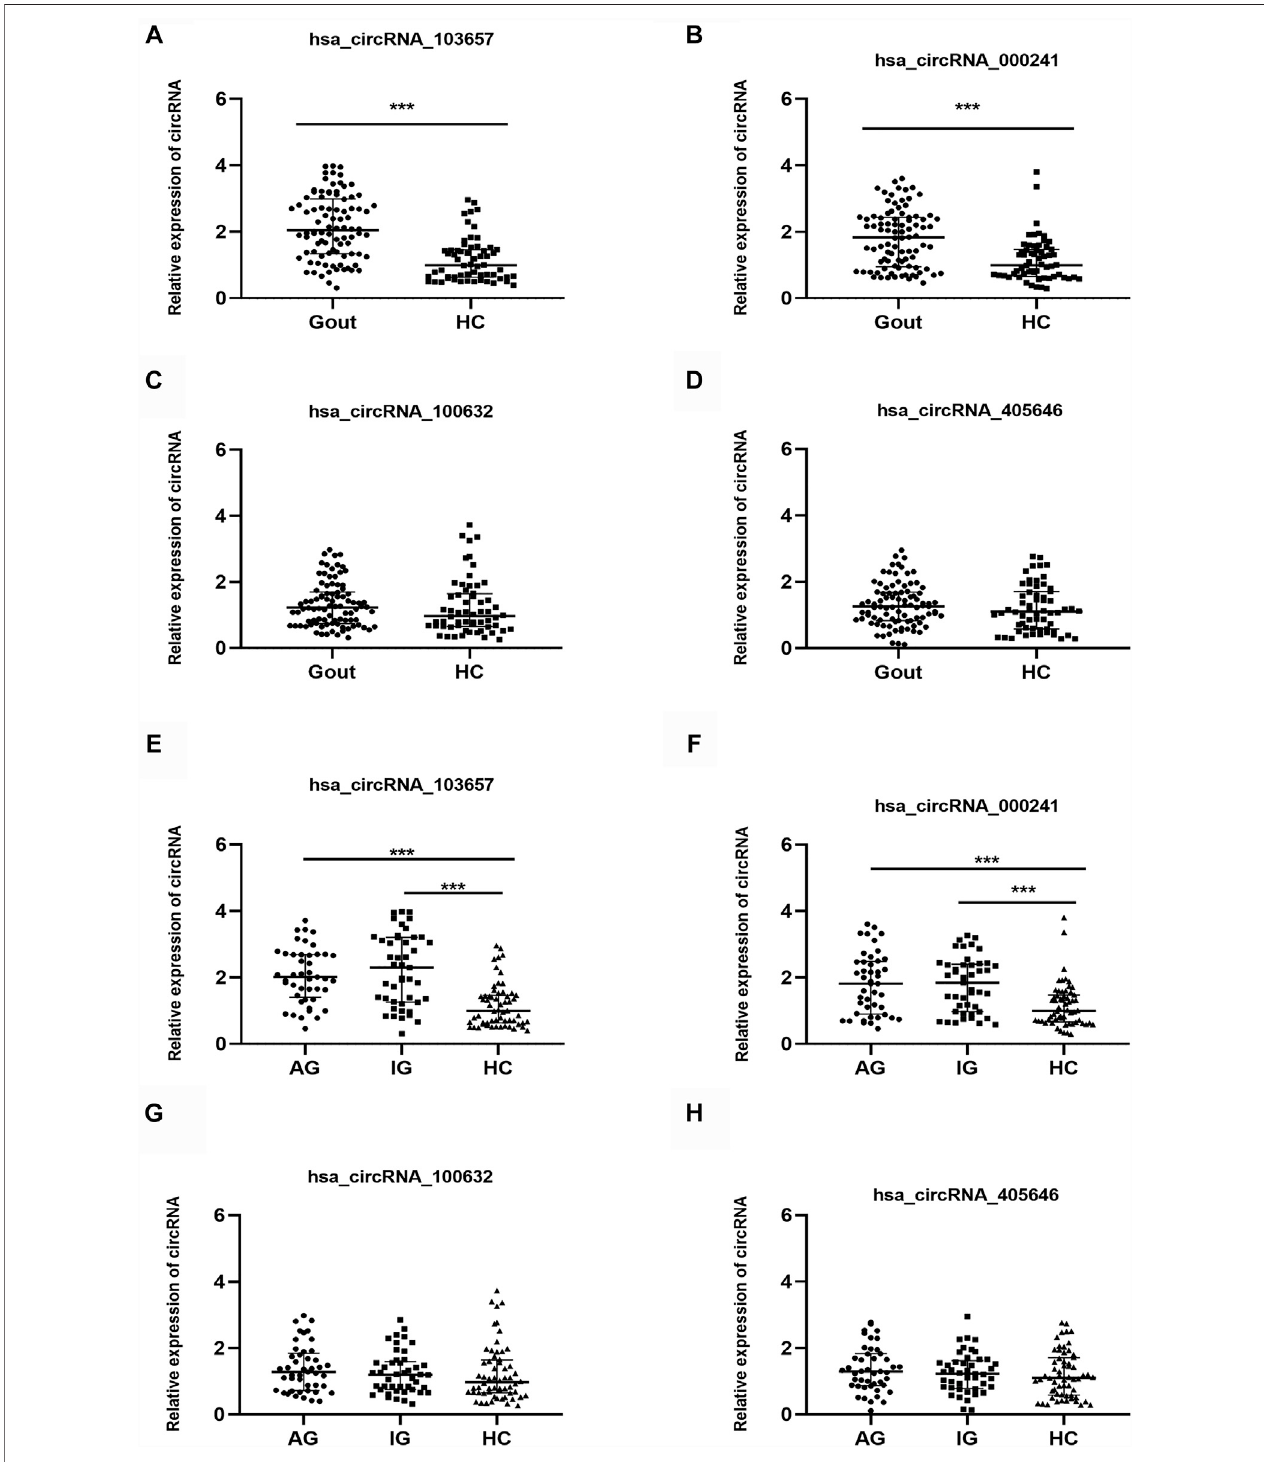
FIGURE 2 | Expression levels of the four circRNAs in gout patients and healthy control subjects. (A, B, C, D) Relative expression levels of the four circRNAs in 90 goutpatientsand60healthycontrol(HC)subjects. (E,F,G,H) RelativeexpressionlevelsofthefourcircRNAsin45acutegoutglare(AG)patients,45intercriticalgout(IG) patients,and60HC.Gout:primarygout,includingacutegout fl areandintercriticalgout;AG:patientswithacutegout fl are;IG:patientswithintercriticalgout;HC:healthy controls; *** p < 0.001.